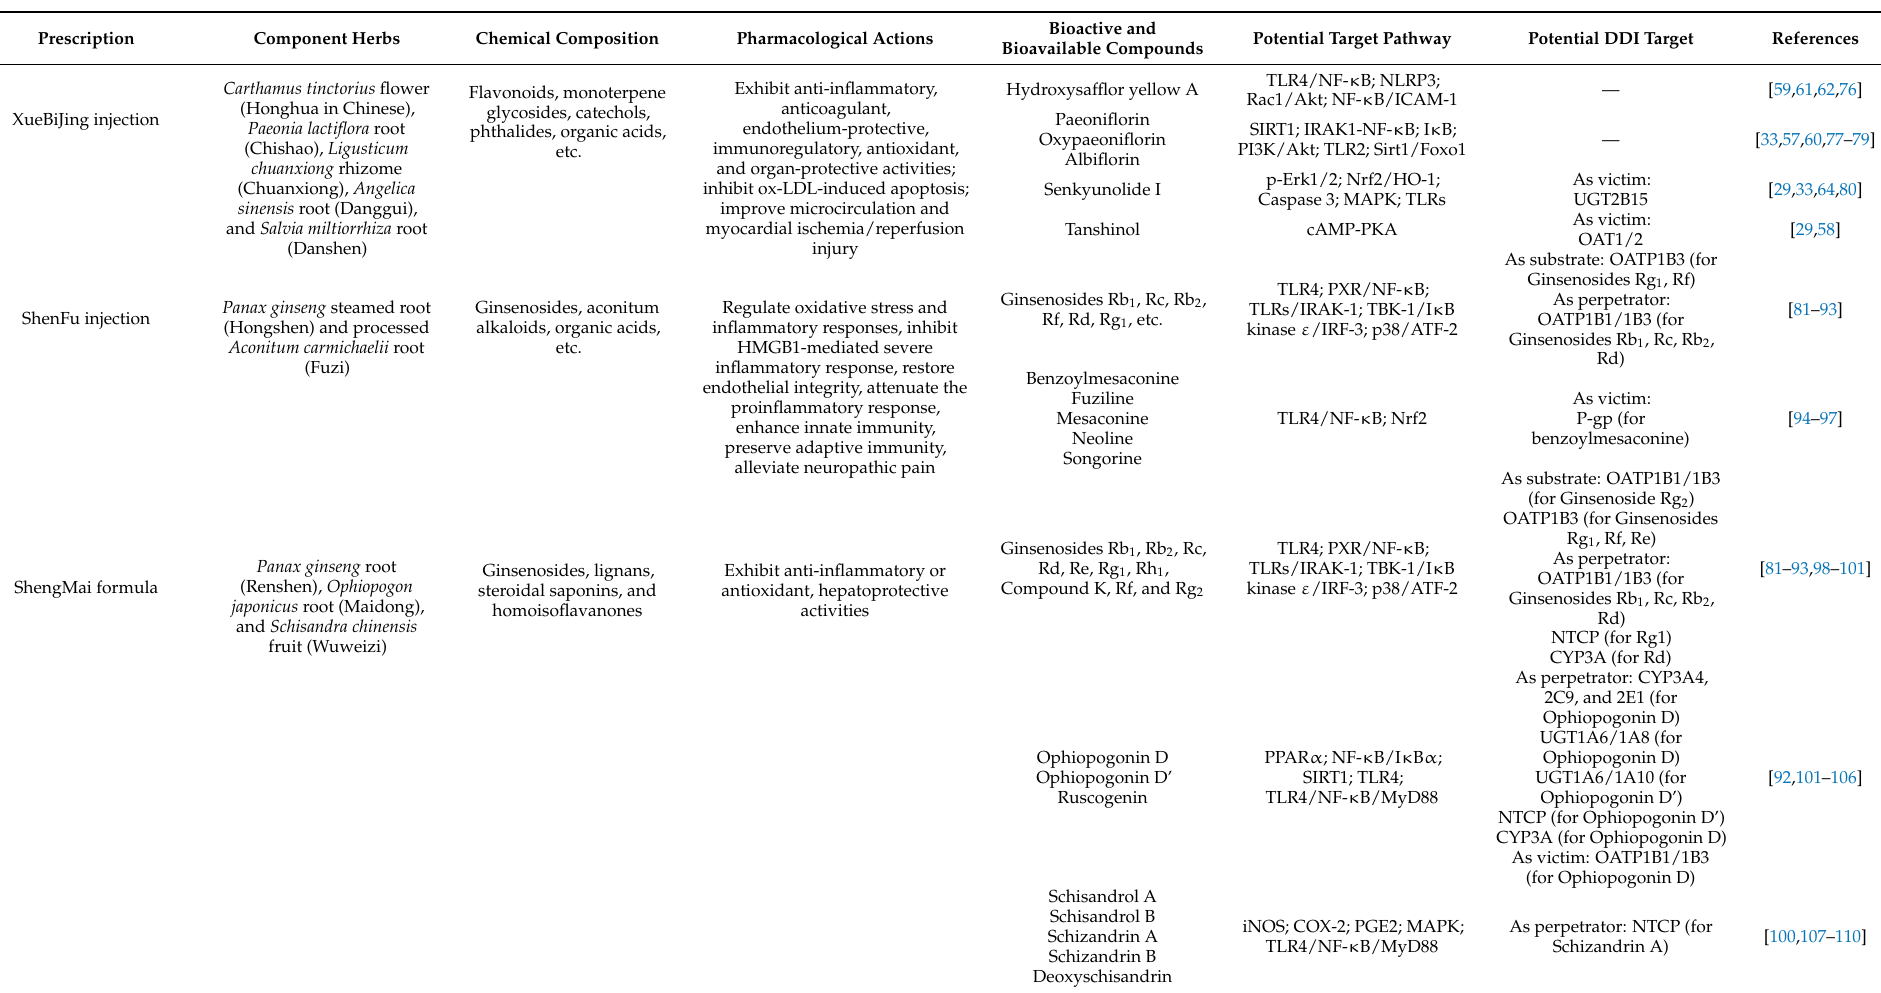
Table 1. Chemical compositions, pharmacological actions, bioactive compounds, and mechanisms of action of representative antisepsis Chinese herbal